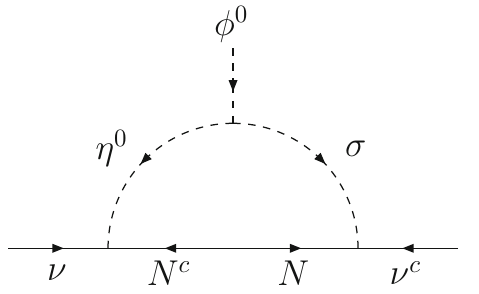
Fig. 1 One-loop diagram for scotogenic U ( 1 ) χ Dirac neutrino